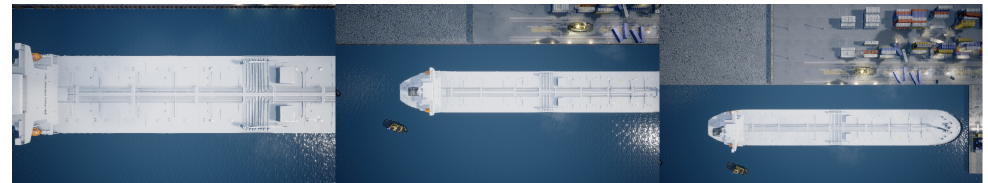
Figure 4. Images from the simulation environment captured at different